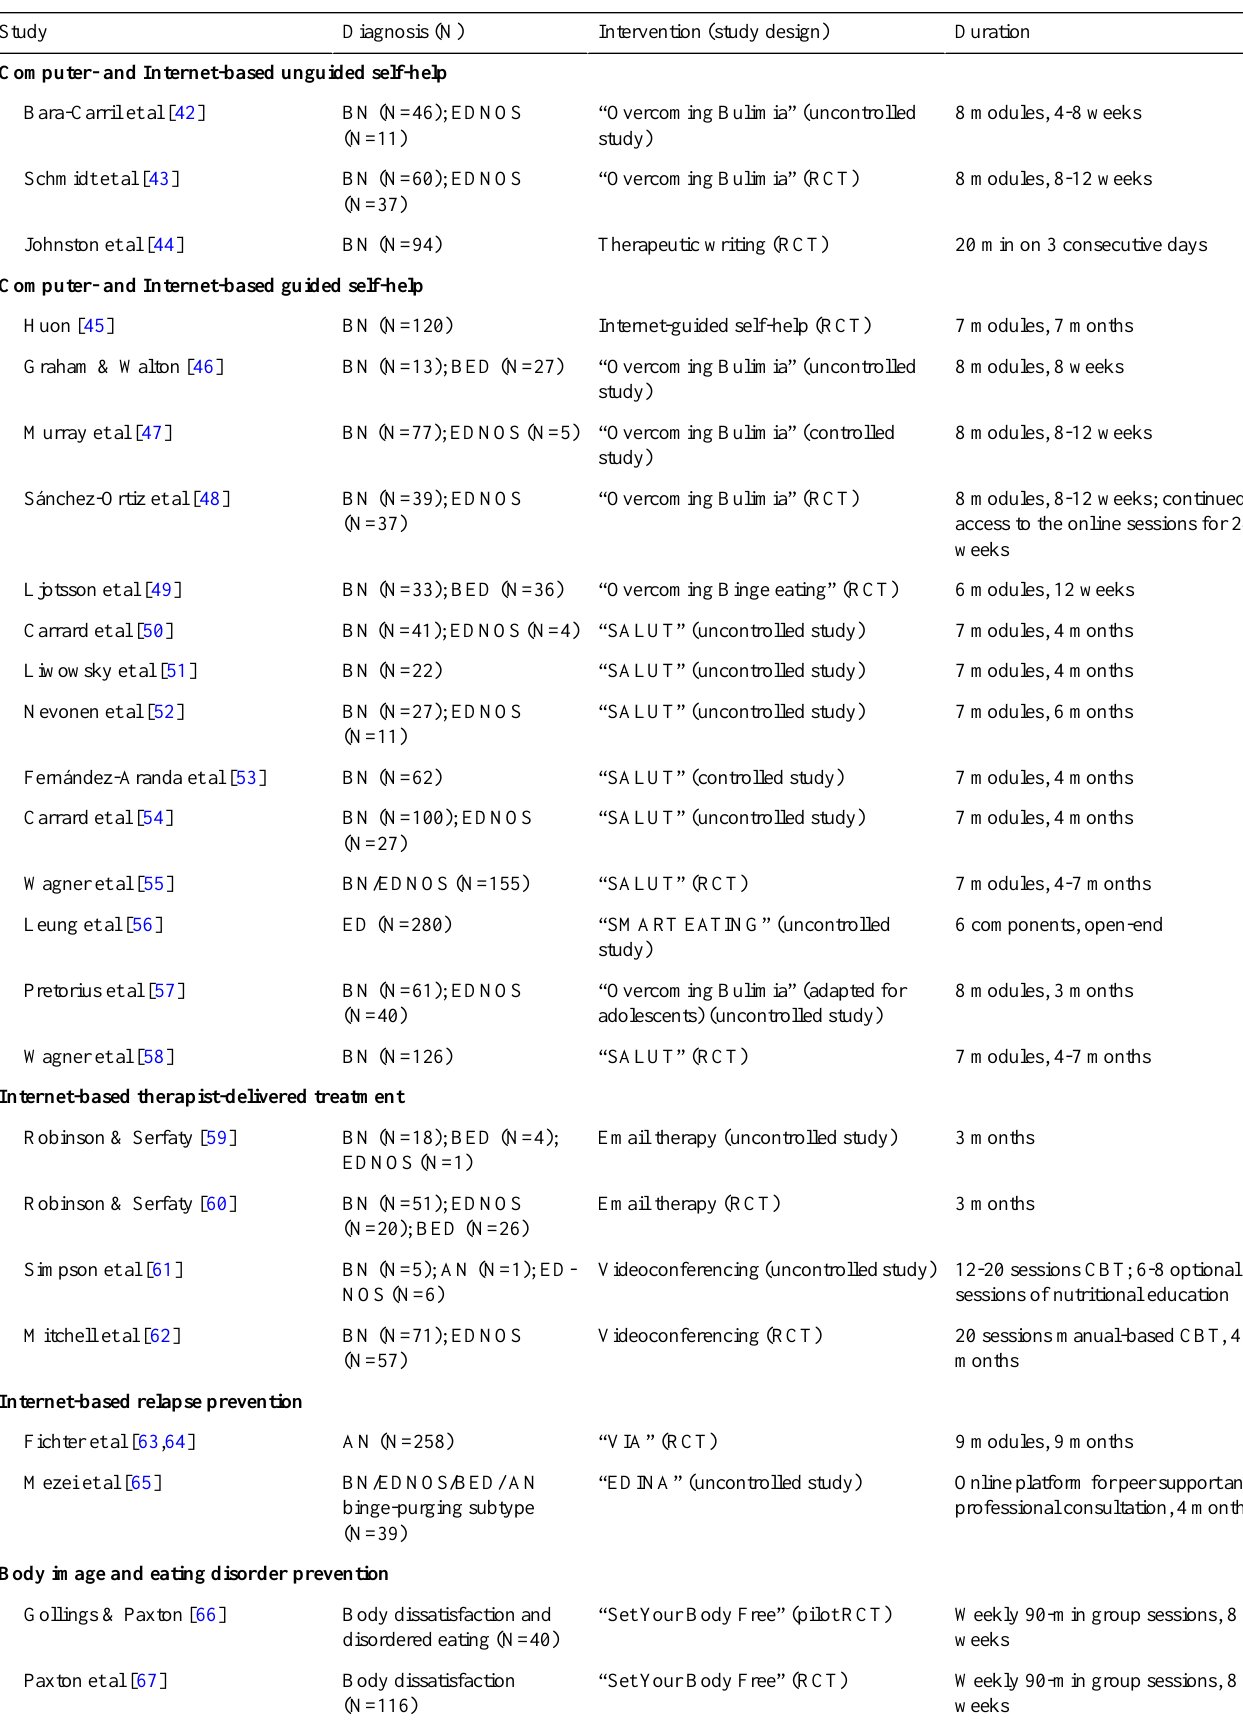
Table 1. Studies evaluating efficacy of computer- and Internet-based treatment for eating disorders. a